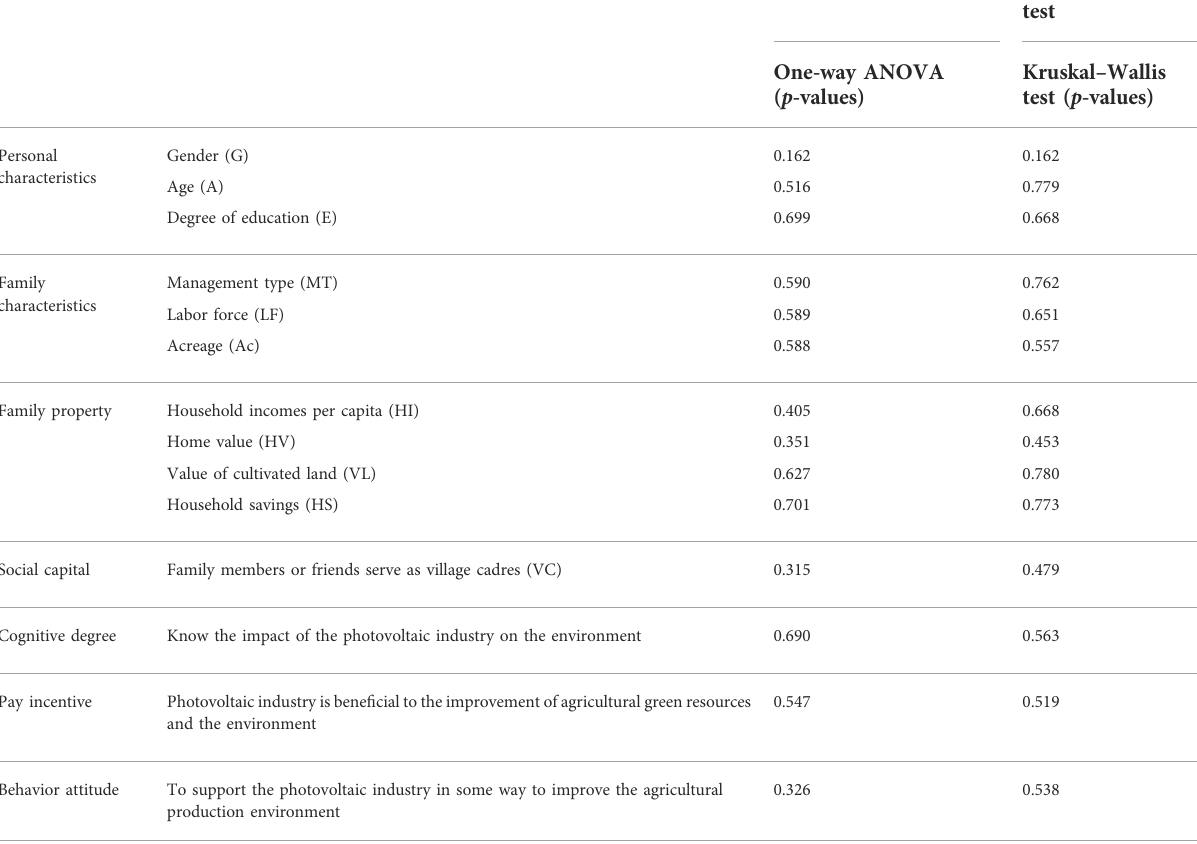
TABLE 5 Signi fi cance tests of socio-demographic